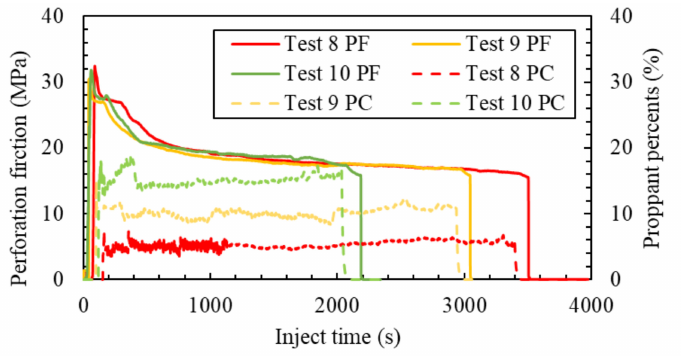
Figure 8. Perforation friction vs. injection time at different proppant concentrations (PF denotes perforation friction, PC denotes proppant